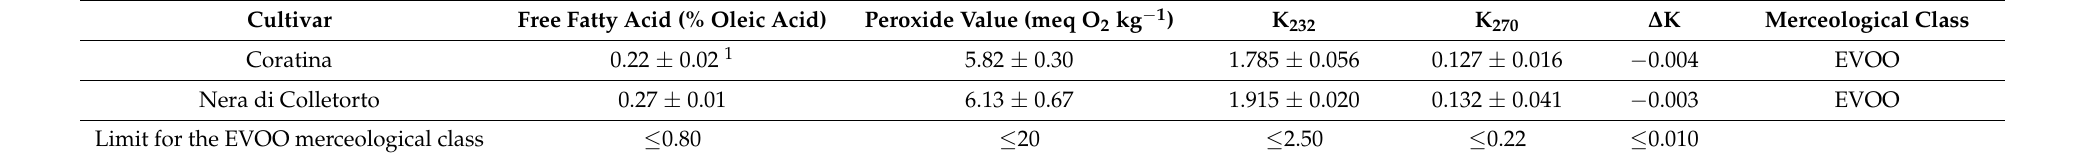
Table 2. Analytical indices of freshly produced extra virgin olive oil from two monocultivars subjected to filtration.